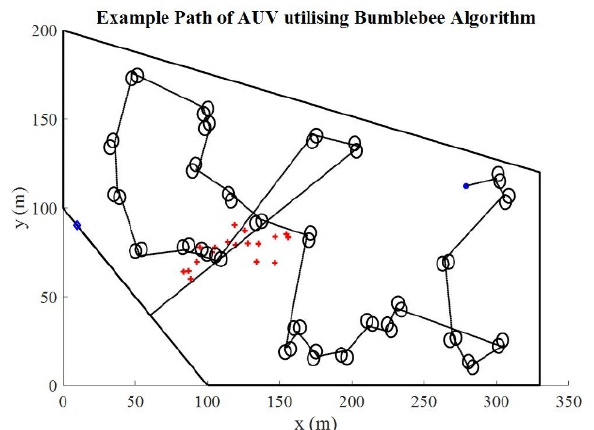
Figure 17. Example path of the bumblebee (BB) search algorithm, start and end point of the autonomous underwater vehicle (AUV) are marked by the blue circle and diamond respectively; positions of submarine groundwater discharges (SGDs) are marked by red crosses.